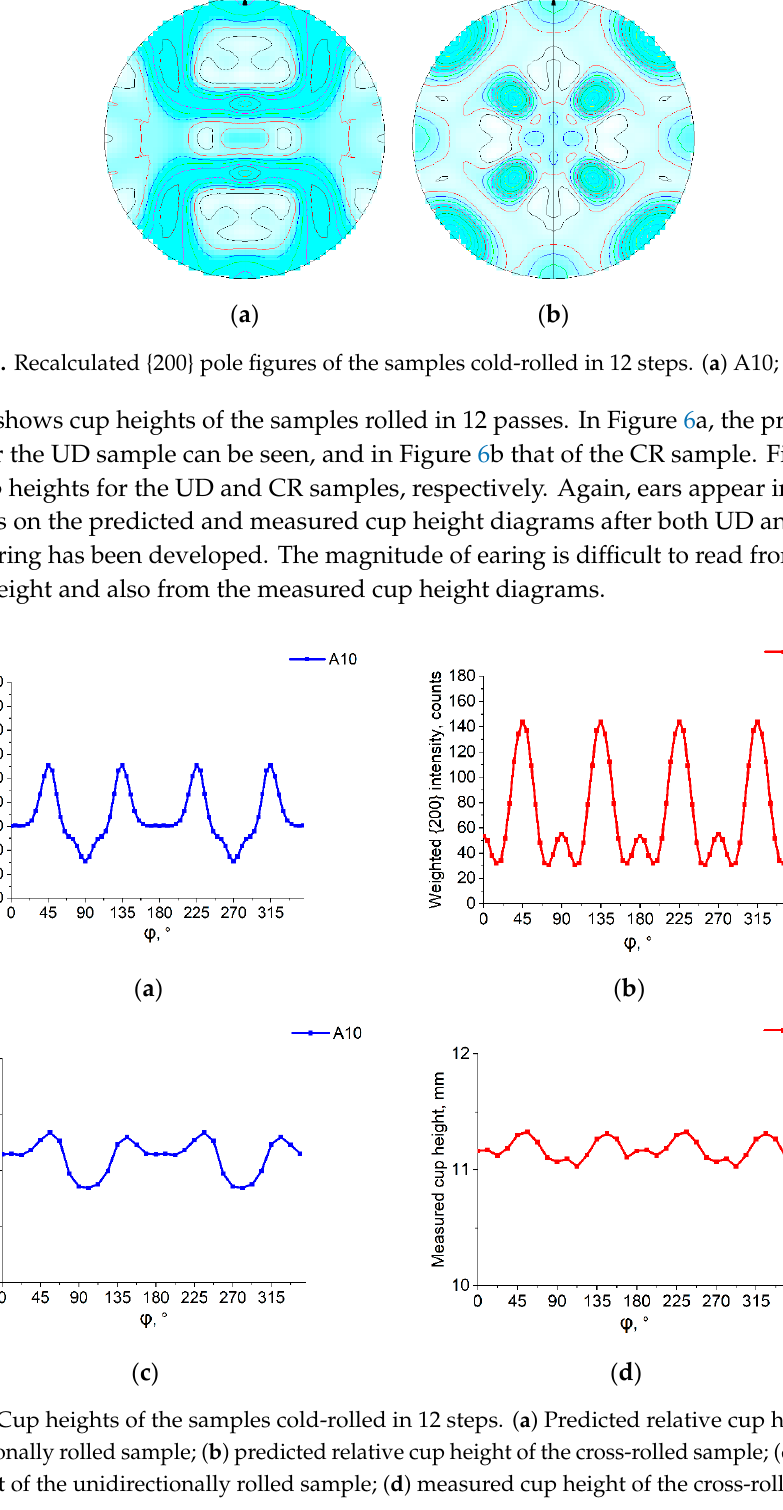
( b ) Figure 7. Absolute value of average earing of the samples cold-rolled in 12 steps. ( a ) Measured and predicted average earing of the unidirectionally rolled sample, scaling factor: 40; ( b ) measured and predicted average earing of the cross-rolled sample, scaling factor: 60. 4. Discussion It was seen that after both 6 and 12 passes, the cross-rolled, 5056 type aluminum sheets exhibited more uniform, four-folded {200} pole figures compared to unidirectionally rolled sheets. In accordance, a notably smaller value of rolling-type earing (~1.5) was observed after cross-rolling compared to the unidirectionally rolled sheets (~2.2–2.5). As a consequence, a different scaling factor was required to predict average earing in the case of cross-rolling (60 instead of 40) even if all other parameters (including the parameters of cold rolling, texture measurements, deep-drawing, blank geometry, etc.) are unchanged. Finally, it can be concluded that besides unidirectional rolling, the developed method can be applied for cross-rolling as well. Author Contributions: Conceptualization, M.B.; methodology, M.B.; validation, A.H. and B.S.; formal analysis, M.B.; investigation, M.B., A.H. and B.S.; data curation, B.S. and H.A.; writing—original draft preparation, M.B.; writing—review and editing, H.A.; visualization, B.S.; supervision, V.M.; funding acquisition, M.B. All authors have read and agreed to the published version of the manuscript.